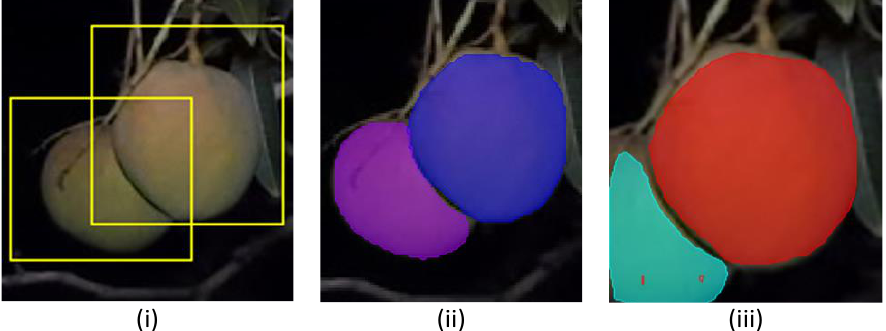
Figure 3. Example of model outputs for: ( i ) YOLOv4-tiny bounding box on detected fruits; ( ii ) Mask R-CNN instance segmentation on image tile; ( iii ) instance segmentation applied to bounding box produced by a YOLOv4-tiny detection model.